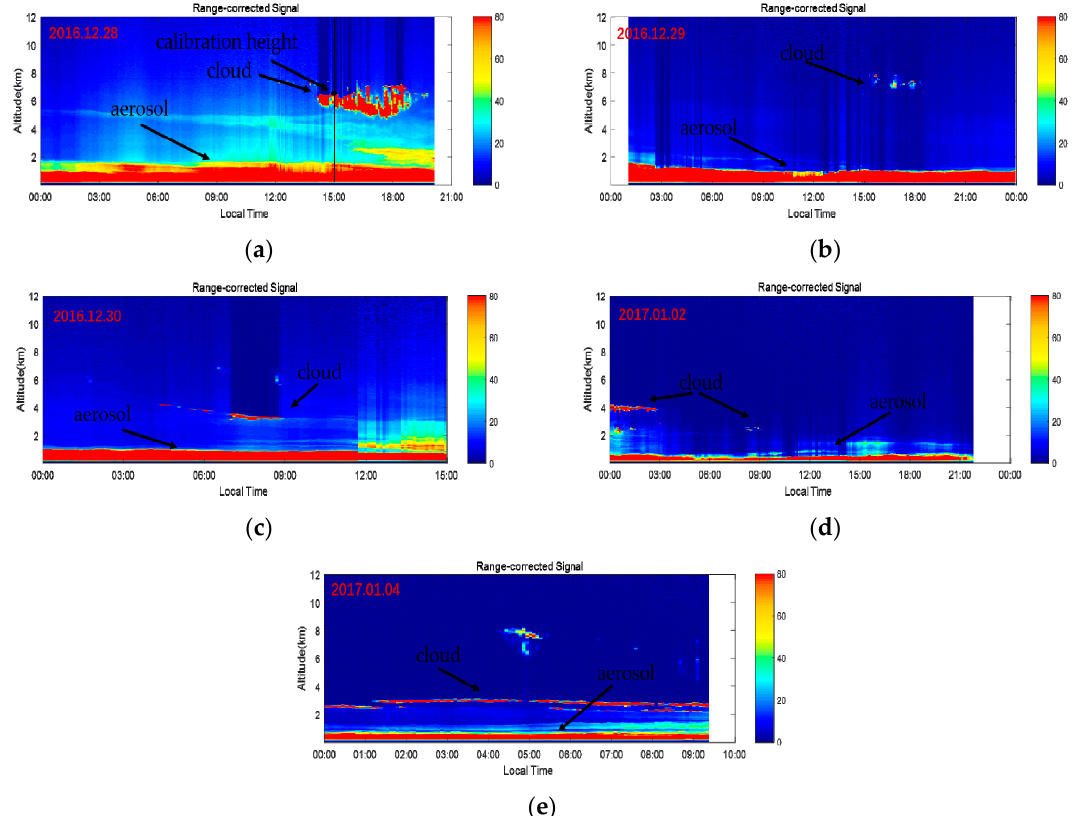
Figure 2. Vertical profile of range-corrected signal: ( a ) December 28 00:00–20:00; ( b ) December 29, 01:05–23:55; ( c ) December 30 00:00–10:40 and 11:00–14:55; ( d ) January 2 00:00–22:00; ( e ) January 4 00:00–9:20.